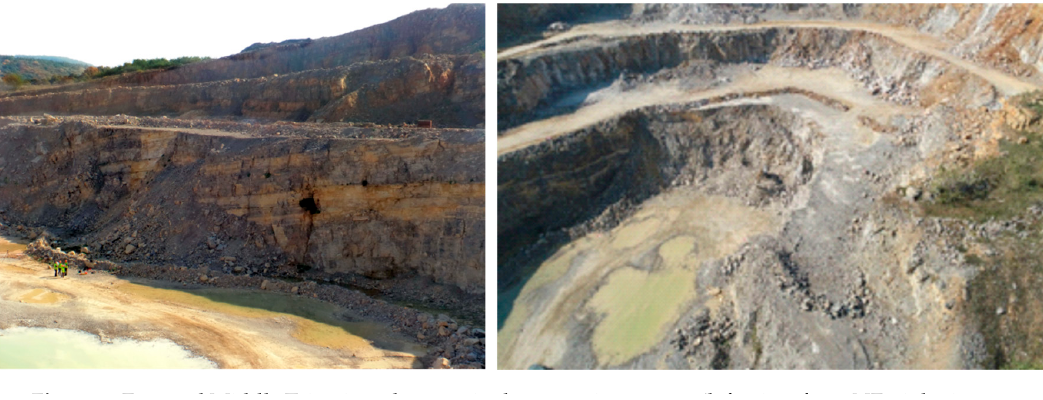
Figure 2. Exposed Middle Triassic carbonates in the operating quarry (left: view from NE, right: image captured from the UAV).